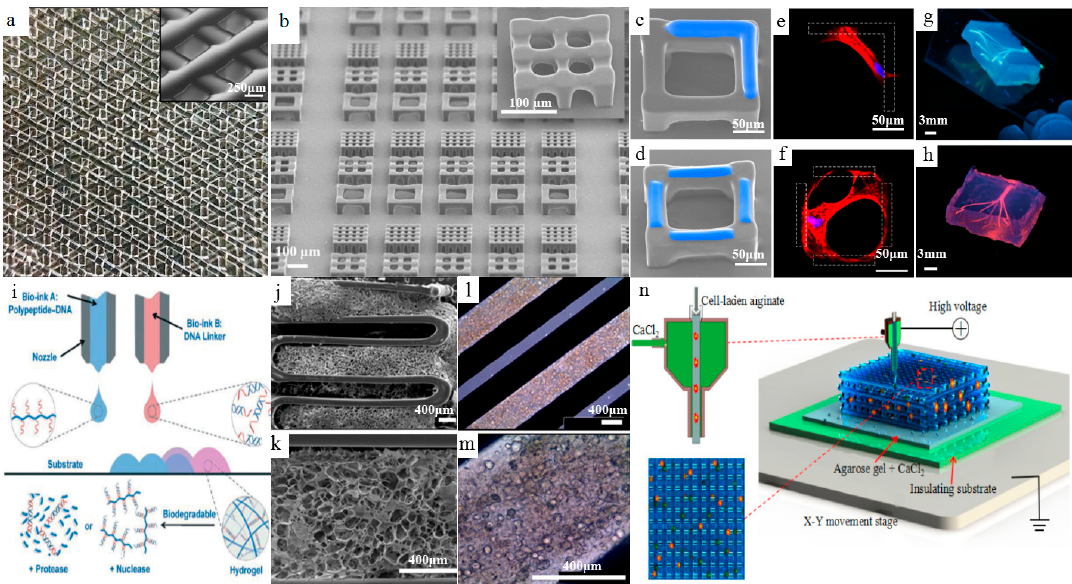
Figure 6. Bioprinted hydrogels. ( a ) Macroscopic view of additive-manufactured five-layer gelatin. Inset: Magnification of scaffold porosity, reprinted from [61] with the permission of Nature Publishing Group, Copyright 2017; ( b ) SEM images of 3D cubic microscaffolds via vat photopolymerization process. ( c , d ) SEM images of the cubic microscaffolds with in situ printed GelMA (blue); ( e , f ) the fluorescent staining of f-actin (red) and nuclei (blue) of the human mesenchymal stem cells (hMSCs) cultured in the corresponding microscaffolds (gelation shown as the dashed area), reprinted from [62] with the permission of Nature Publishing Group, Copyright 2017; ( g ) Photographs of the bioprinted agarose templates (green); ( h ) Respective microchannels perfused with a fluorescent microbead suspension (pink, diameter of microchannels: 500 µ m), reprinted from [63] with the permission of Royal Society of Chemistry, Copyright 2014. ( i ) Scheme of 3D bioprinting of the polypeptide–DNA hydrogel, reprinted from [66] with the permission of John Wiley and Sons, Copyright 2017; ( j , k ) SEM images of hybrid structure of cartilage decellularized extracellular matrix (cdECM) with PCL framework; ( l , m ) microscopic images of cell-printed structure of adipose decellularized extracellular matrix (adECM) with PCL framework, reprinted from [69] with the permission of Nature Publishing Group, Copyright 2014; ( n ) Schematic of coaxial nozzle-assisted electrohydrodynamic cell printing, reprinted from [73] with the permission of WHIOCE publishing, Copyright